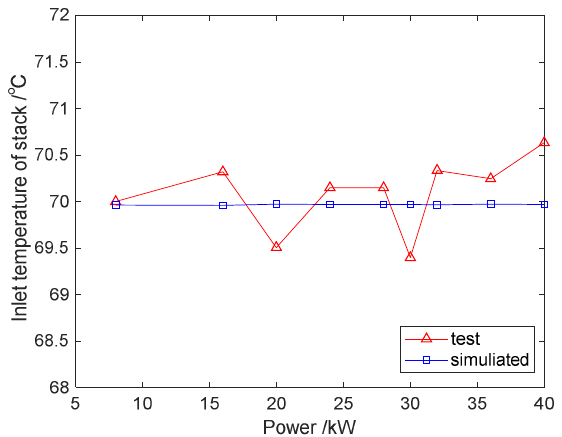
Figure 4. Model verification.